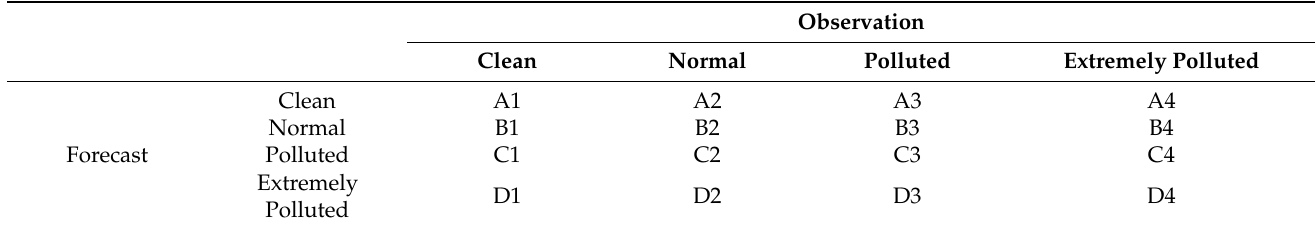
Table 2. Contingency table for the categorical forecasts. Observation Clean Normal